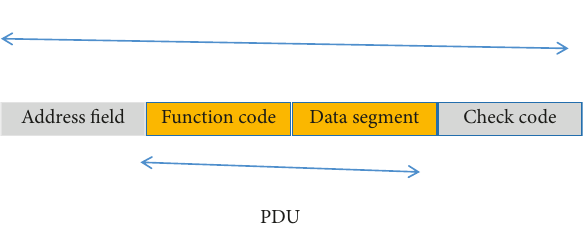
Figure 13: Modbus general frame